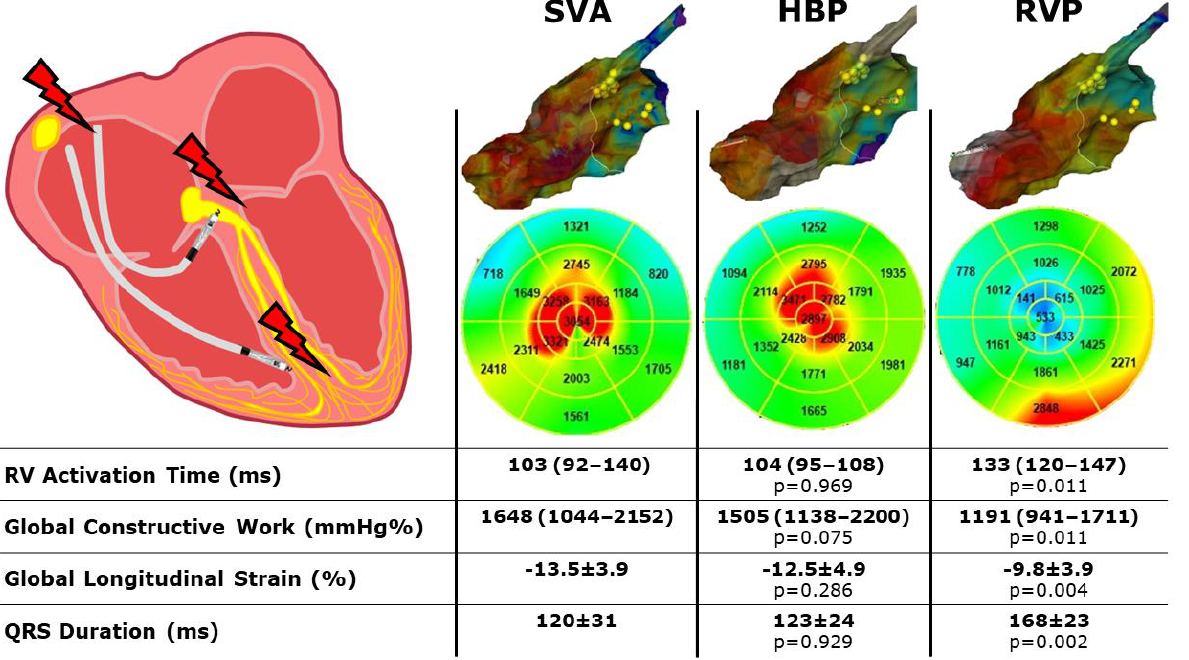
Figure 4. Central illustration. Three dimensional high-density electroanatomical mapping and myocardial work performance during spontaneous rhythm, His bundle pacing and right ventricular pacing. SVA: spontaneous ventricular activation; HBP: His bundle pacing; RVP: right ventricular pacing; RV: right ventricle. p values are considered vs SVA.